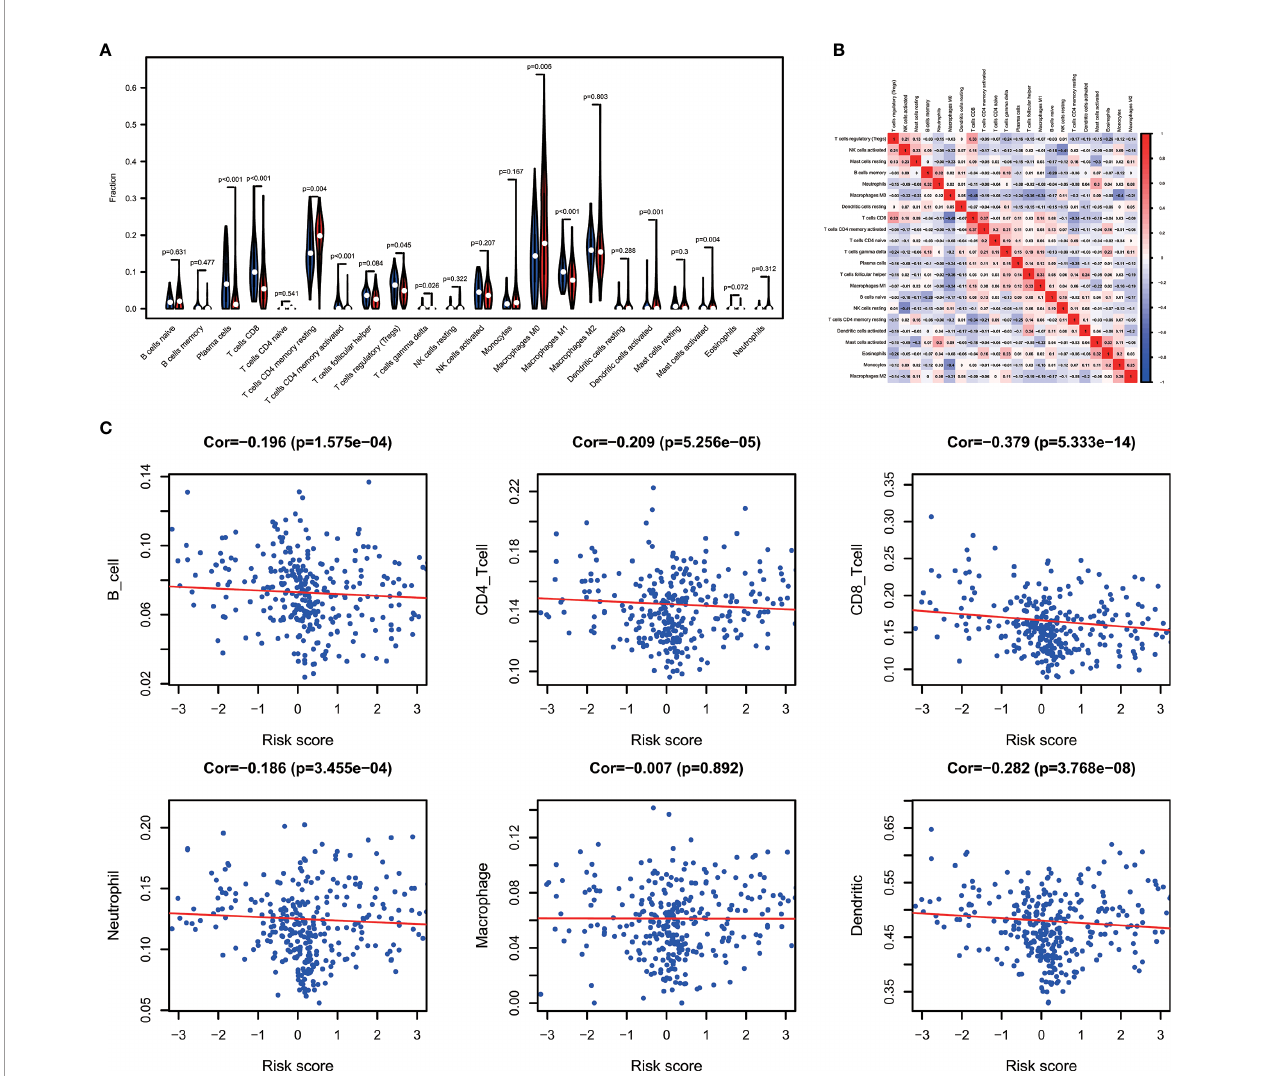
FIGURE 5 | Immune landscapes of the low- and high-risk OV patients. (A) The proportion of different types of immune cells in high and low risk groups. Low-risk groups share a higher fraction of Plasma cells (P<0.001), T cells CD8 (P<0.001), T cells CD4 memory activated (P<0.001), T cells regulatory (P=0.045), T cells gamma delta (P=0.026) and Macrophages M1 (P<0.01). (B) Correlation matrix of all 22 immune cell proportions. (C) Correlations between risk score and immune in fi ltrating level of 6 types of immune